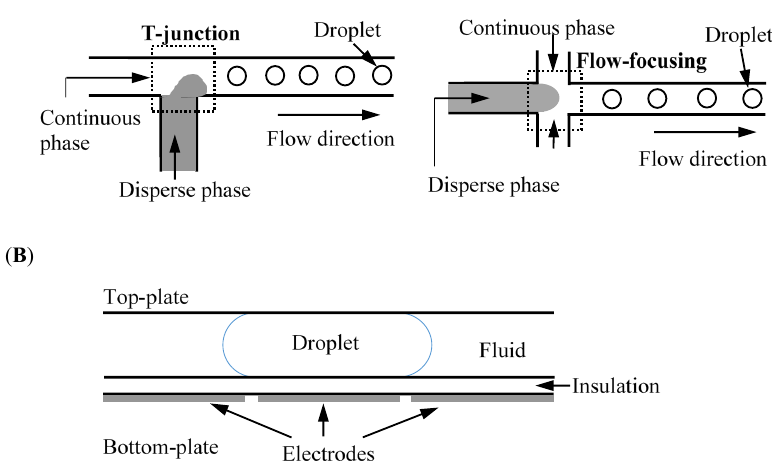
Figure 1. The two major types of droplet microfluidics. ( A ) Continuous-flow emulsion-based droplet microfluidics from T-junction and flow-focusing; ( B ) Electrowetting-based droplet microfluidics.